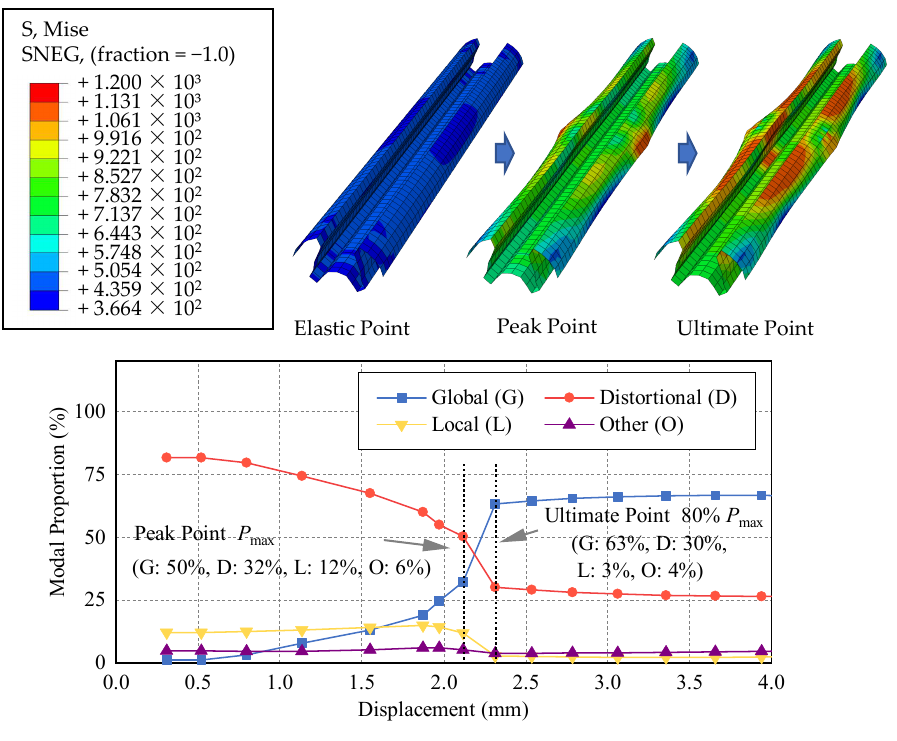
Figure 19. Full range modal participation of FS260.